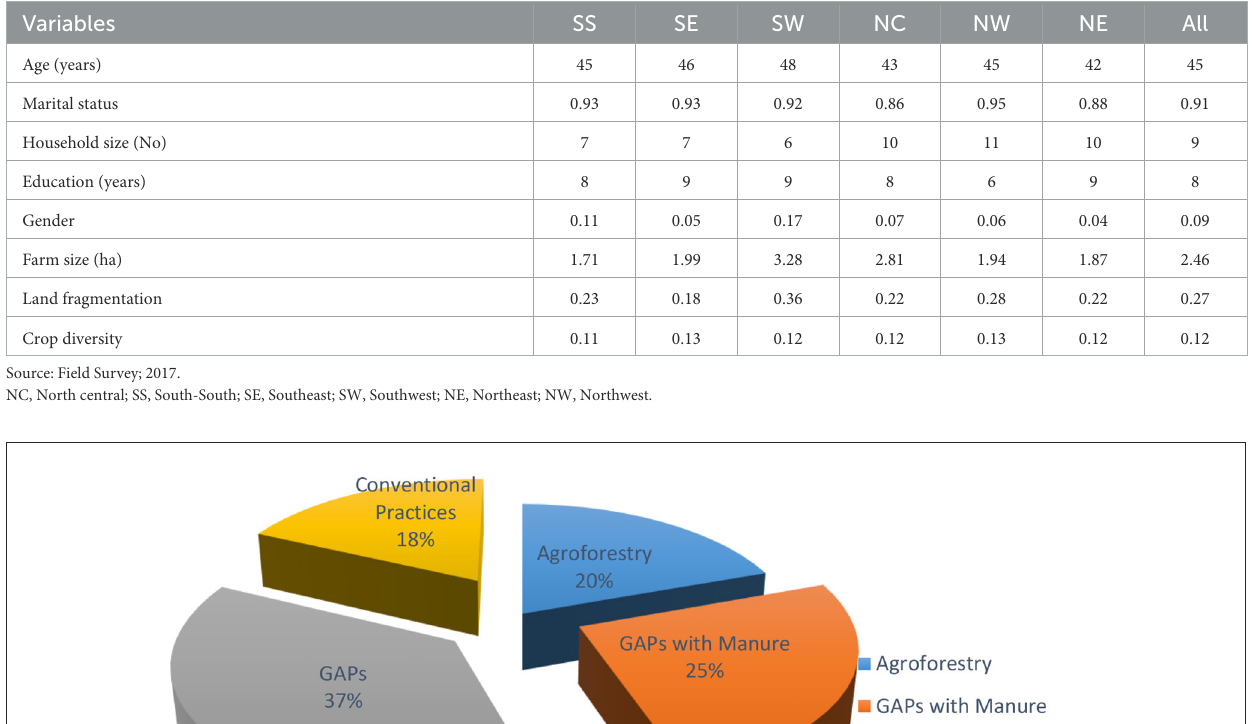
TABLE 2 Socioeconomic distribution of farmers in Nigeria by geopolitical zones.